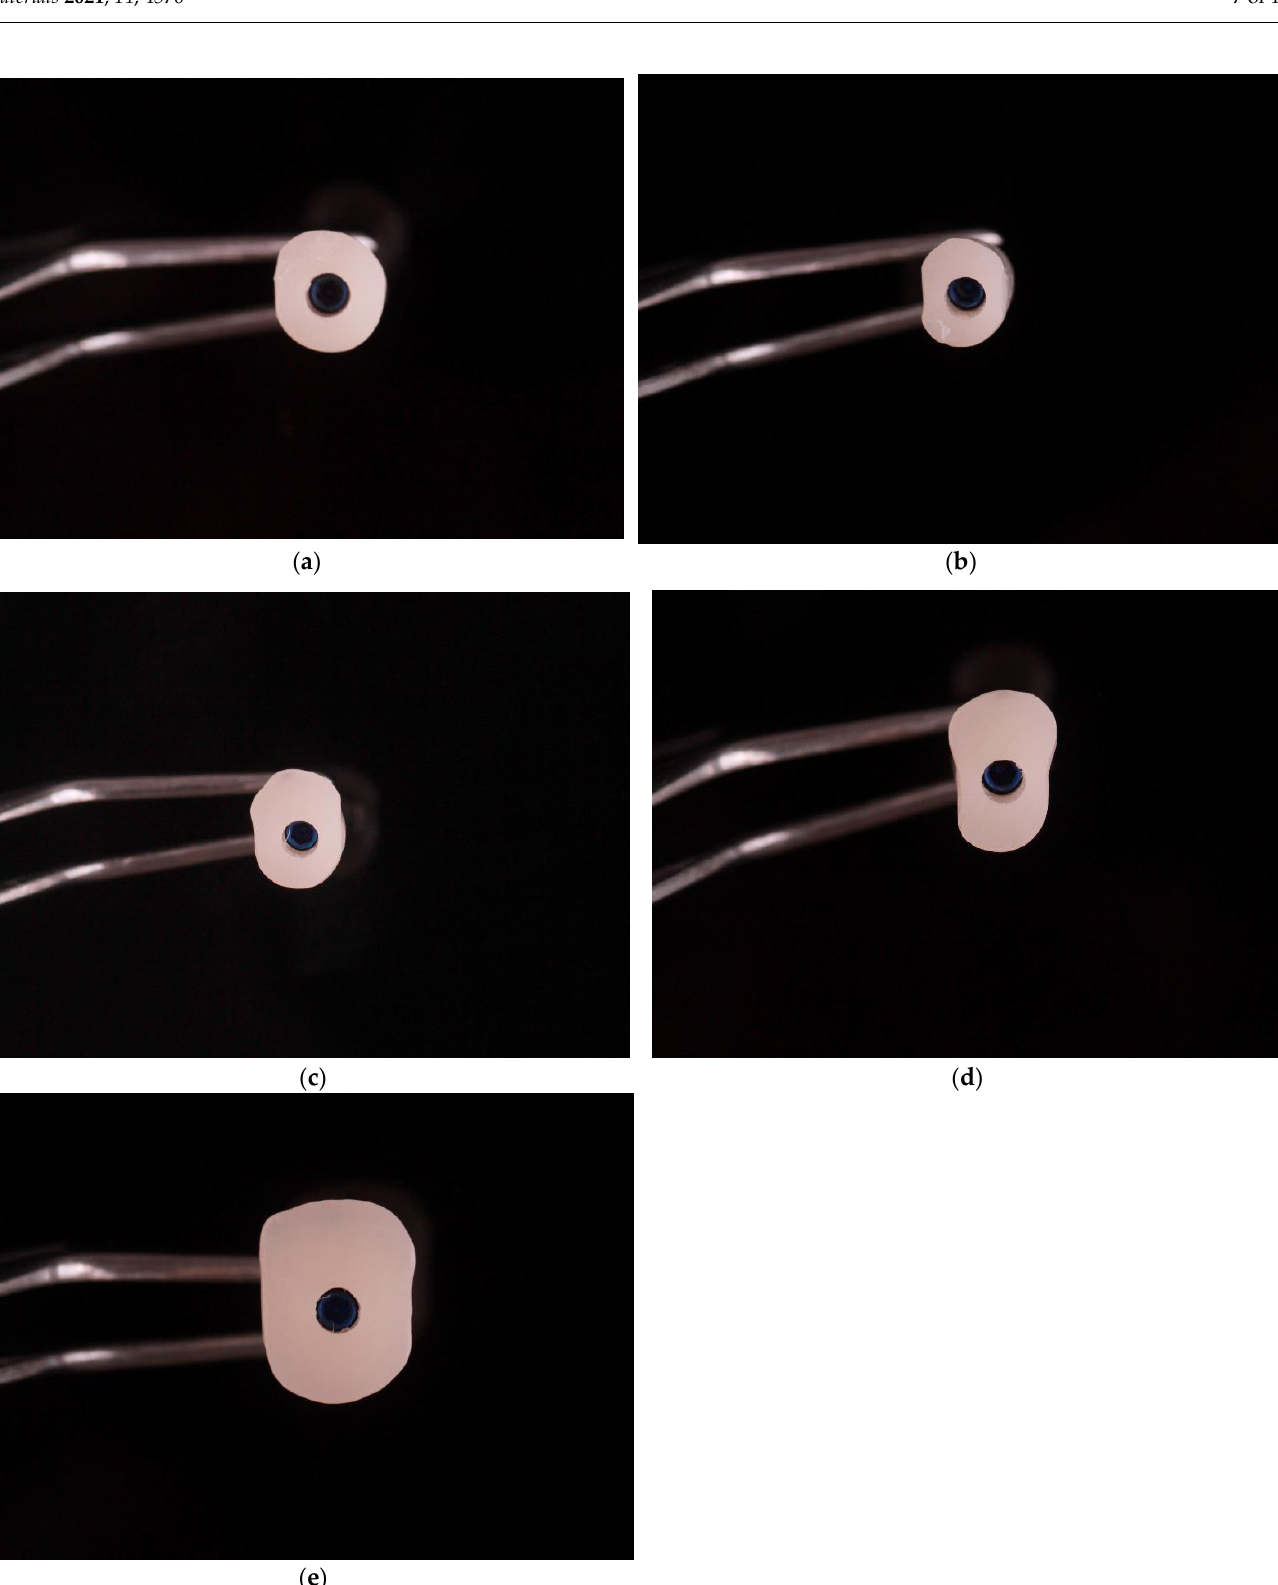
Figure 5. Milled zirconium anatomical healing abutment for the ( a ) central incisor, ( b ) lateral incisor, ( c ) canine, ( d ) first premolar, and ( e ) first molar in upper jaw.